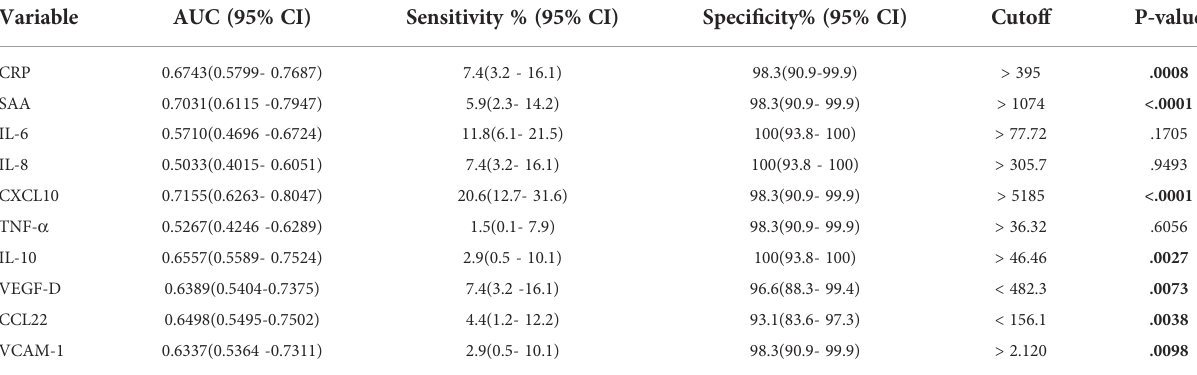
TABLE 8 Area under the receiver operating characteristic curve, sensitivity, speci fi city & cutoff values of speci fi c markers in discriminating mild/ moderate and severe COVID-19 patients.